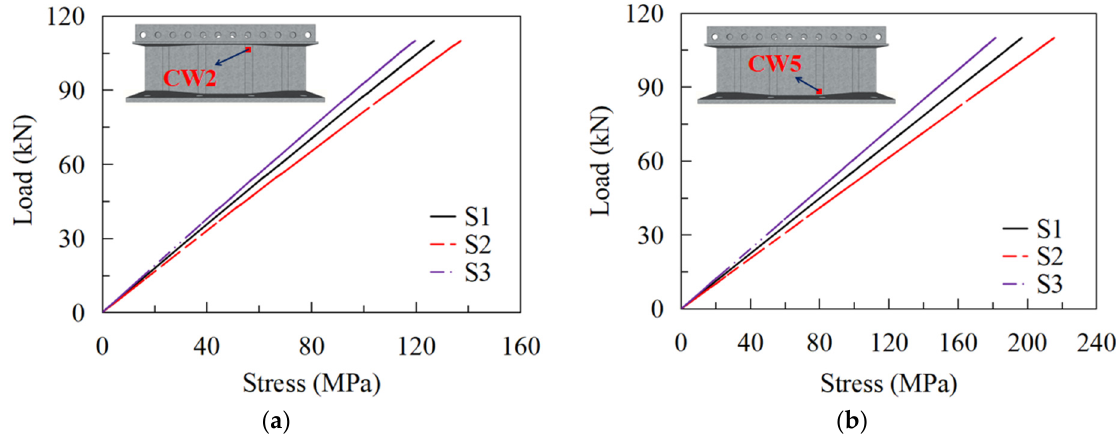
Figure 20. Load-stress curves for models with different bend radii: ( a ) CW2; ( b ) CW5.